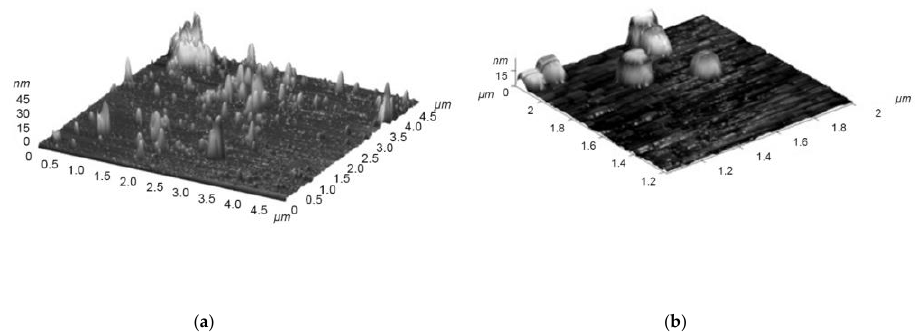
Figure 3. ( a ) 3D AFM image of nanostructures based on systems {Ni(acac) 2 His Tyr} (h = 45 nm) (4.5 µ m × 4.5 µ m); ( b ) 3D AFM image of nanostructures based on systems {Ni(acac) 2 · NMP · Tyr} (h = 25 nm) (2 µ m × 2 µ m).